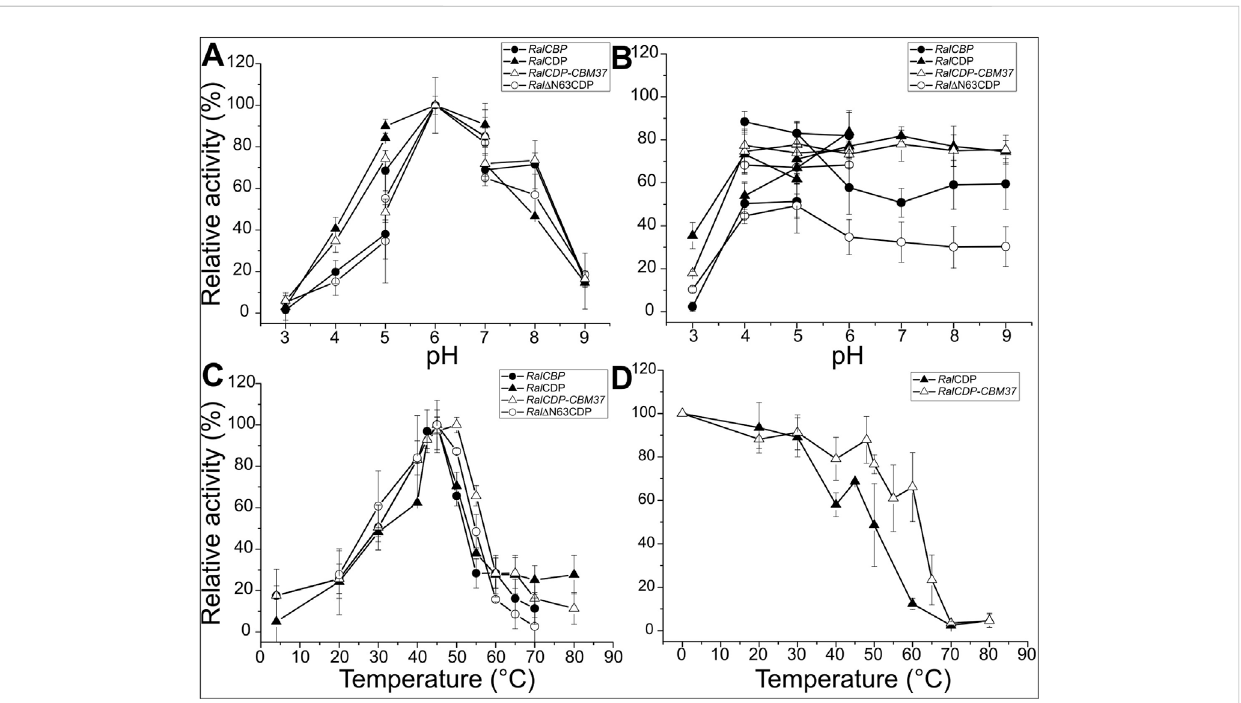
FIGURE 4 Enzymatic activity of Ral CBP (black circles), Ral CDP (black triangles), Ral CDP-CBM37 (white triangles) and Ral Δ N63CDP (white circles) at different pHs (A) . Residual enzymatic activity of Ral CBP (black circles), Ral CDP (black triangles), Ral CDP-CBM37 (white triangles), and Ral Δ N63CDP (white circles) after being incubated for 1 h in different buffer solutions (B) . Enzymatic activity of Ral CBP (black circles), Ral CDP (black triangles), Ral CDP-CBM37 (white triangles) and Ral Δ N63CDP (white circles) at different temperatures (C) . Residual enzymatic activity of Ral CDP (black triangles), Ral CDP-CBM37 (white triangles) after 1 h incubations at different temperatures (D)